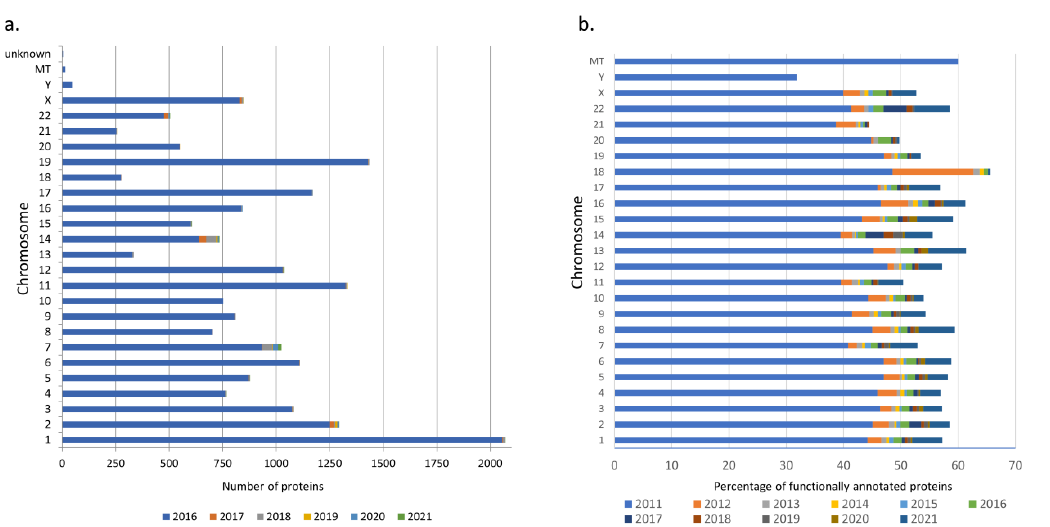
Figure 1. Change in the completeness of human protein data according to neXtProt. ( a ) Chronology of changes in the number of protein identifications; ( b ) chronology of replenishment of neXtProt with information on protein functions.